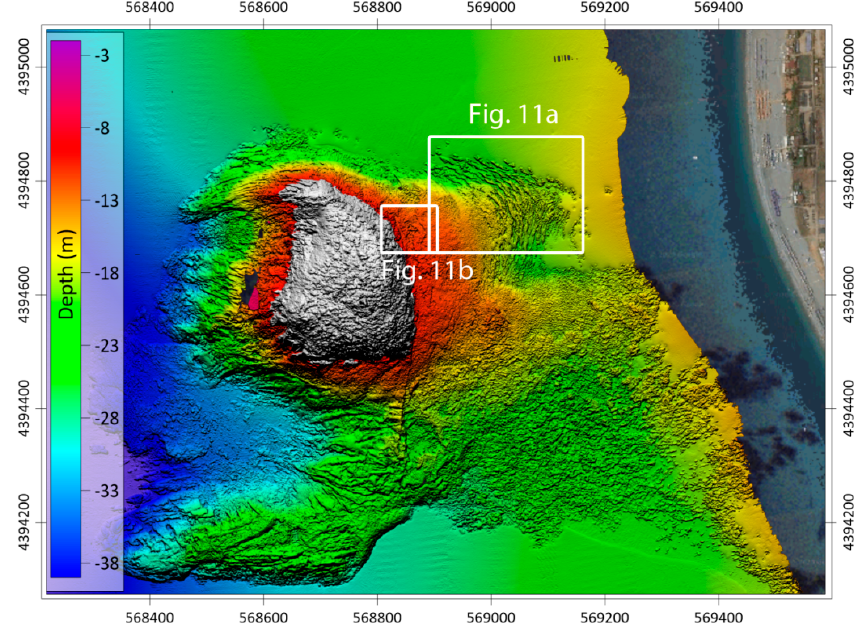
Figure 10. Digital Terrain and Marine Model (DTMM) generated by the optical (UAV) and acoustic (multibeam) data fusion; (a) Area of Interest (AOI) in shallow water; (b) Area of Interest (AOI) in very shallow water. The white boxes are shown in Figure 11.